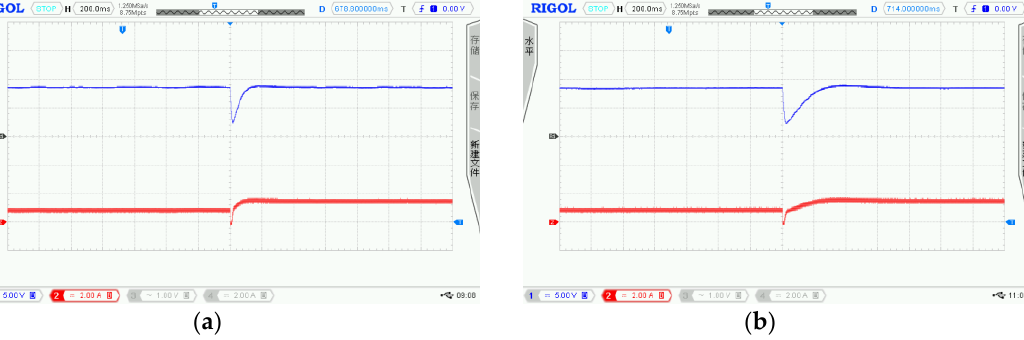
Figure 16. ( a ) LADRC controller: experimental comparison responses with Case 2; and ( b ) PI controller: experimental comparison responses with case 2.